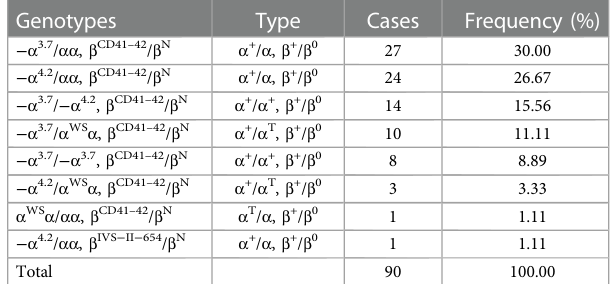
TABLE 4 Distribution of composite α + β thalassemia in the newborns of Li in Hainan province. Genotypes